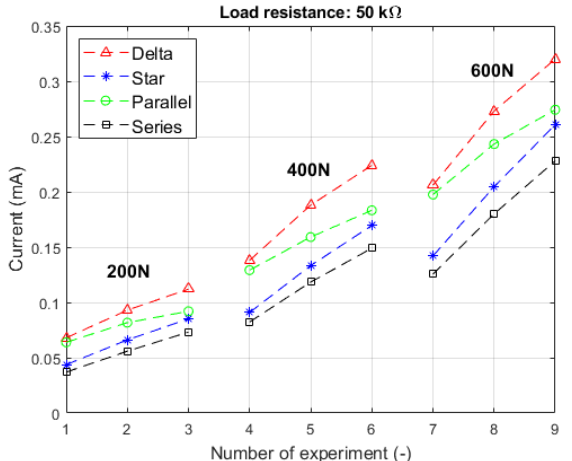
Figure 13. Comparison of current generated by MFC arrays for load resistance equal to 50 kΩ .